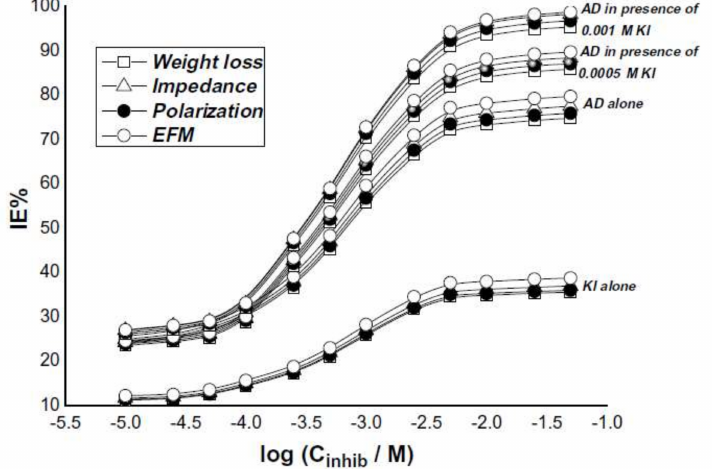
Figure 7. Dependence of the inhibition efficiency values (IE%) obtained from weight loss, polarization, impedance and EFM methods recorded for a LCS in 4.0 M H 2 SO 4 solutions containing different concentrations of KI alone, AD alone and various concentrations of AD in presence of 0.0005 and 0.001 M KI